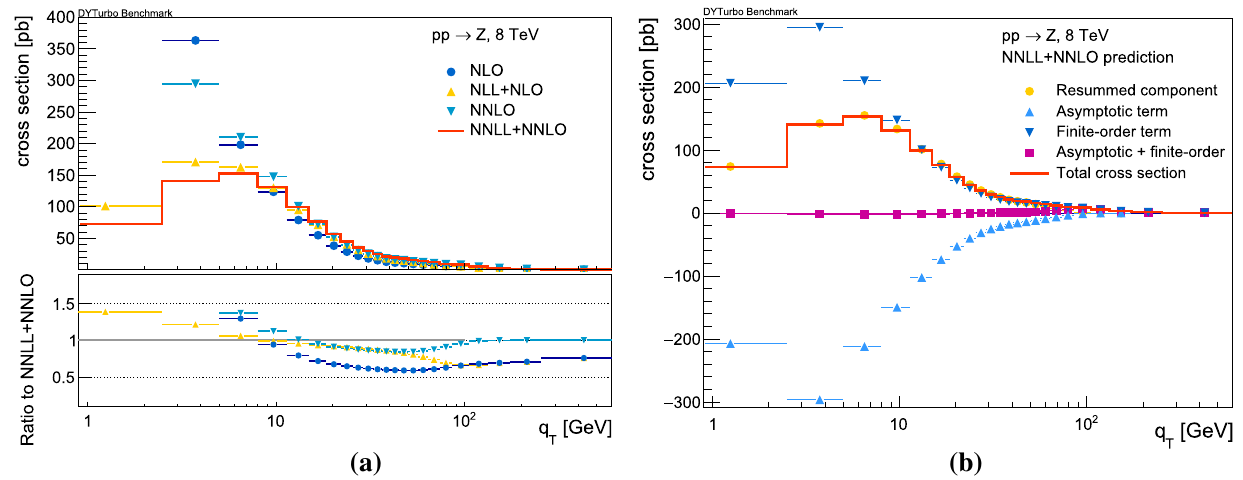
Fig. 1 a DYTurbo results for the Z -boson full-lepton phase space √ s = 8 TeV as a function of the boson transverse cross section at momentum q T at various orders of the calculation (NLO, NLL + NLO, NNLO, and NNLL + NNLO). The bottom panel shows ratios of results at various orders to the NNLL+NNLO result. b DYTurbo results